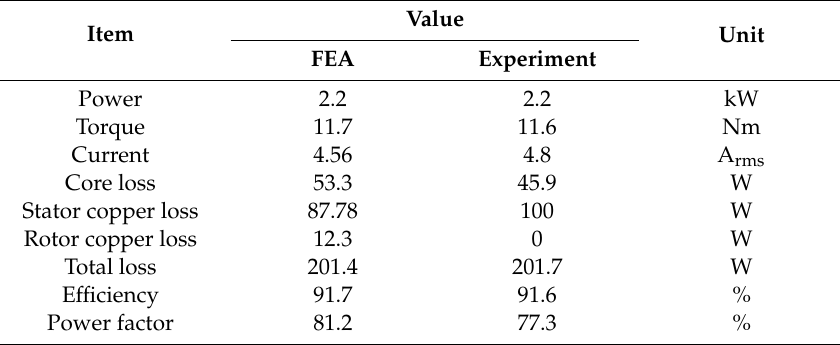
Table 8. Comparison of FEA and experiment